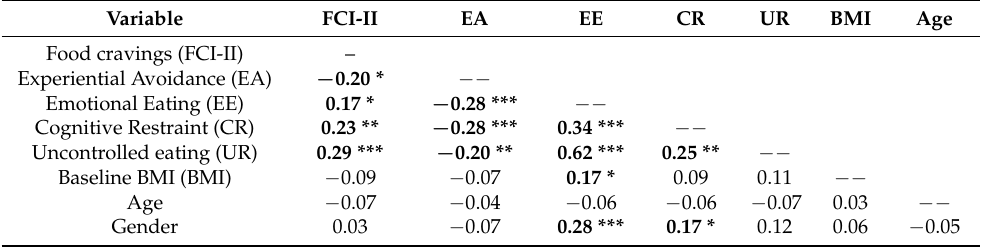
Table 2. Correlation Matrix of Self-report Measures and Demographic Variables in the Present Sample ( n = 174).